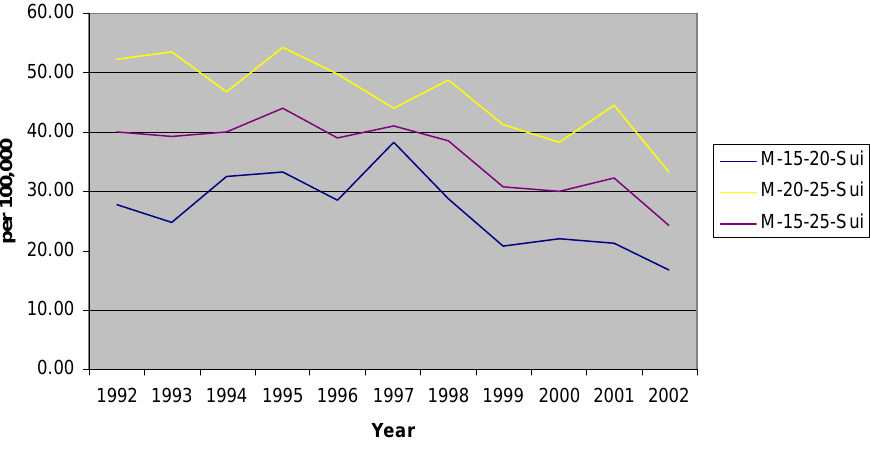
FIGURE 7. Youth suicide, males. Source: